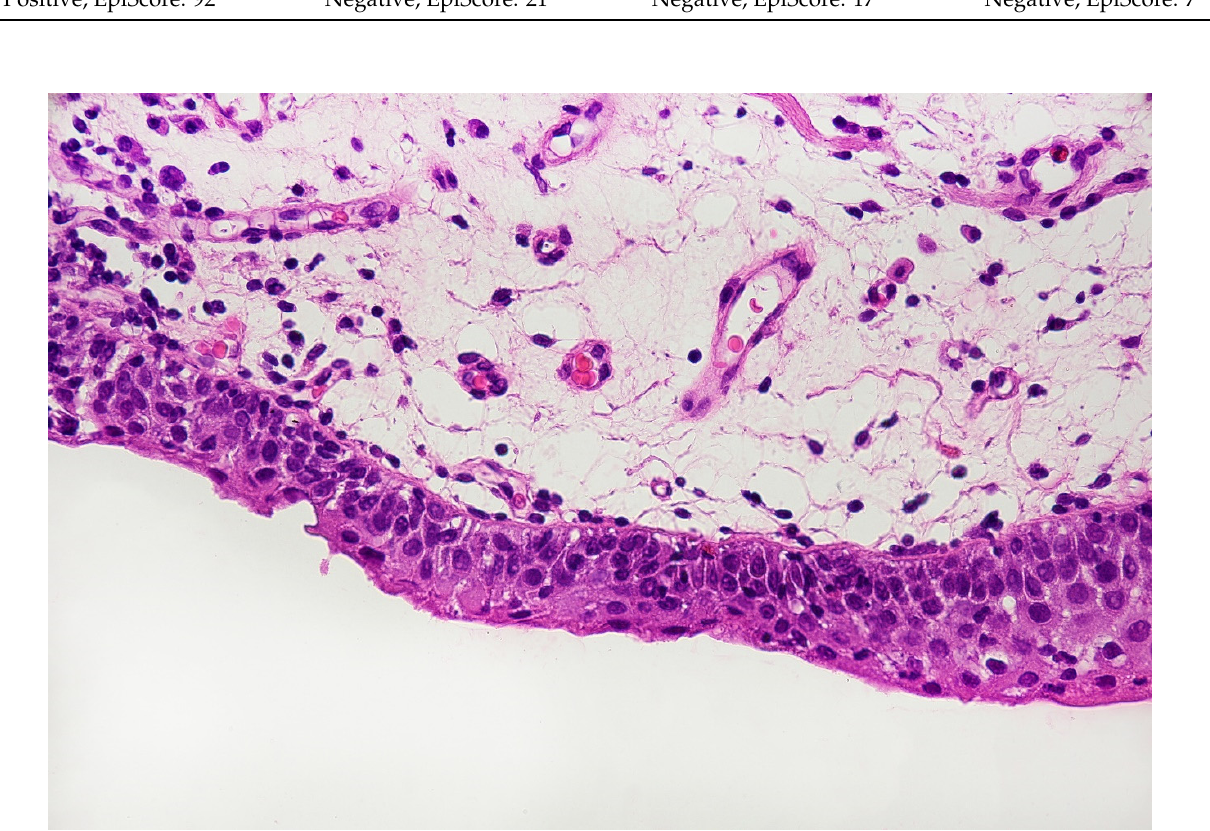
Figure 9. Histopathological specimen—Haematoxylin and Eosin (H&E) staining. The bladder mucosa with signs of hyperaemia and numerous thin-walled blood vessels are visible. Moderately severe inflammatory infiltrations are present with monocular leukocytes. The section is covered with a metaplastic epithelium with the appearance of a flat epithelium. The number of layers of the epithelium is reduced, the cells show no signs of atypia.